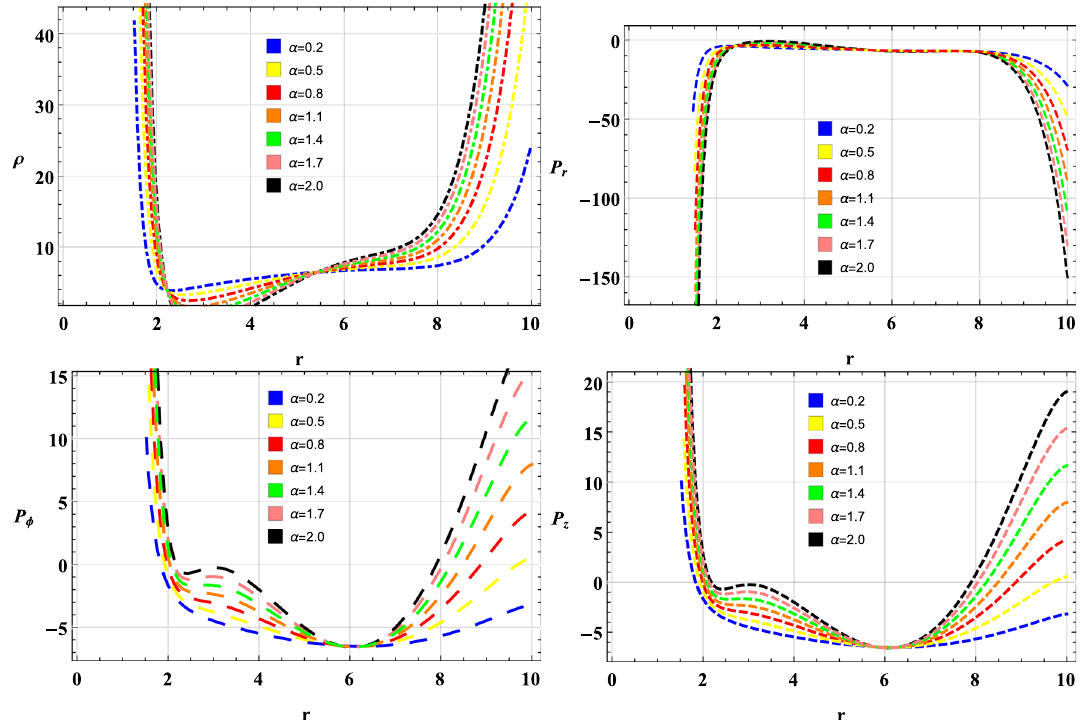
Fig. 9 The graphical variation shows the behavior of ρ (MeV/fm 3 ) , p r (MeV/fm 3 ) , p φ (MeV/fm 3 ) and p z (MeV/fm 3 ) . CASE (C)